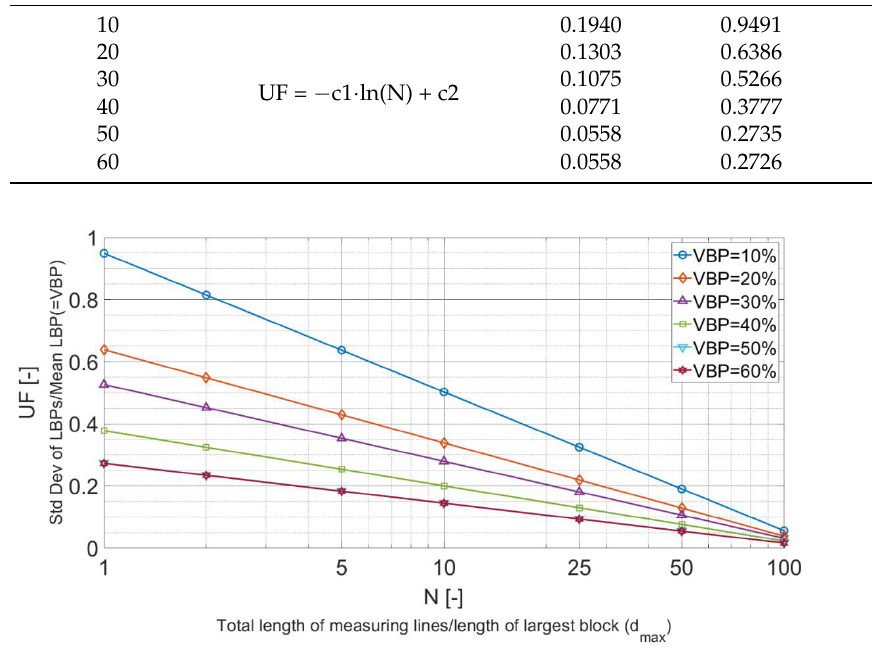
Figure 10. Recommended chart superseding Figure 2b from Medley [49]: Uncertainty in the VBP estimate from LBPs, as a function of the total sampling length. Since the trajectories for the 50% and 60% VBPs are superimposed, the trend for VBP = 70% is assumed to be also co-incident. (Note: symbols on trend lines are line markers and not data points).